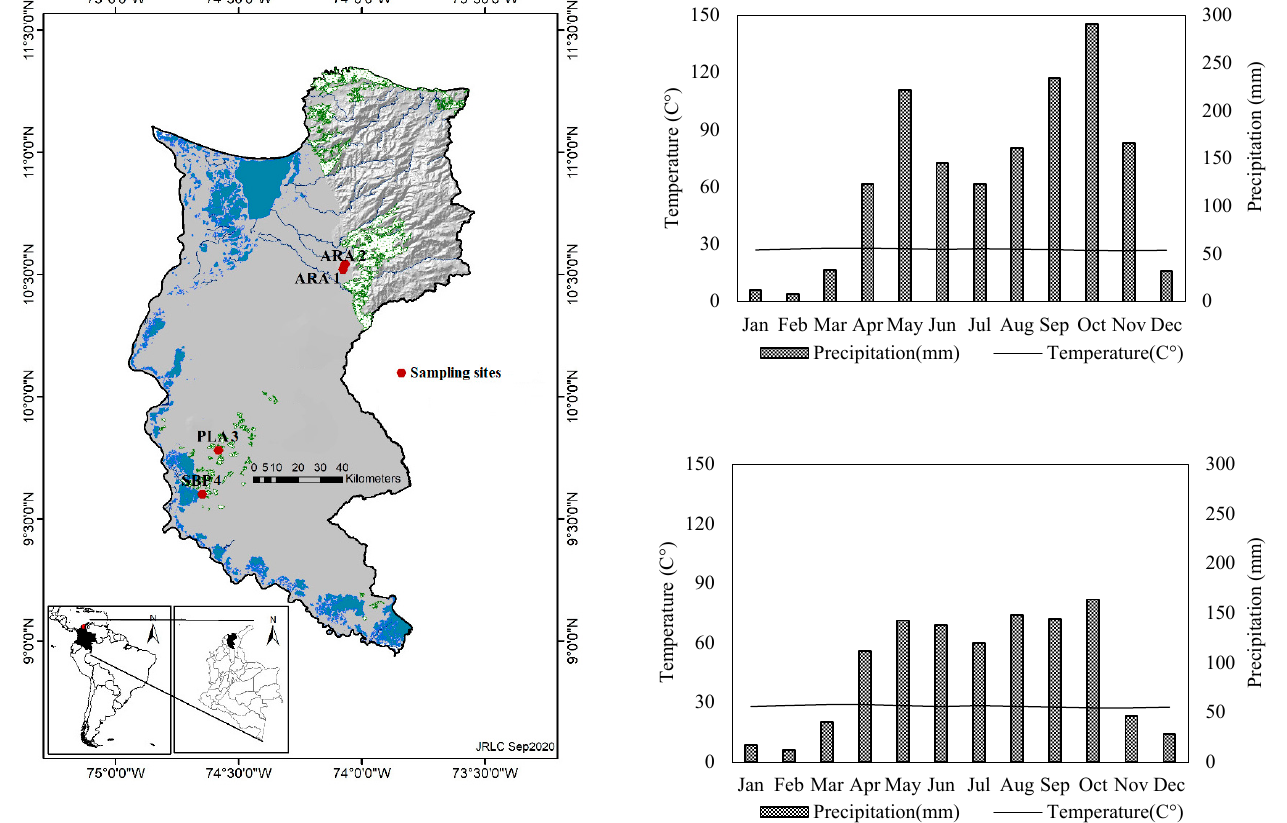
Figure 1. Study area and climatographs indicating air temperature and precipitation. Mountain landscape: ARA 1 and ARA 2; Lomerio landscape: PLA 4 and SBP 5. Annual precipitation and temperature were 1551 mm and 27.4 ◦ C for the Mountain landscape, respectively, and 1112 mm and 28.1 ◦ C for the Lomerio landscape, during the long-term record (1958–2019).